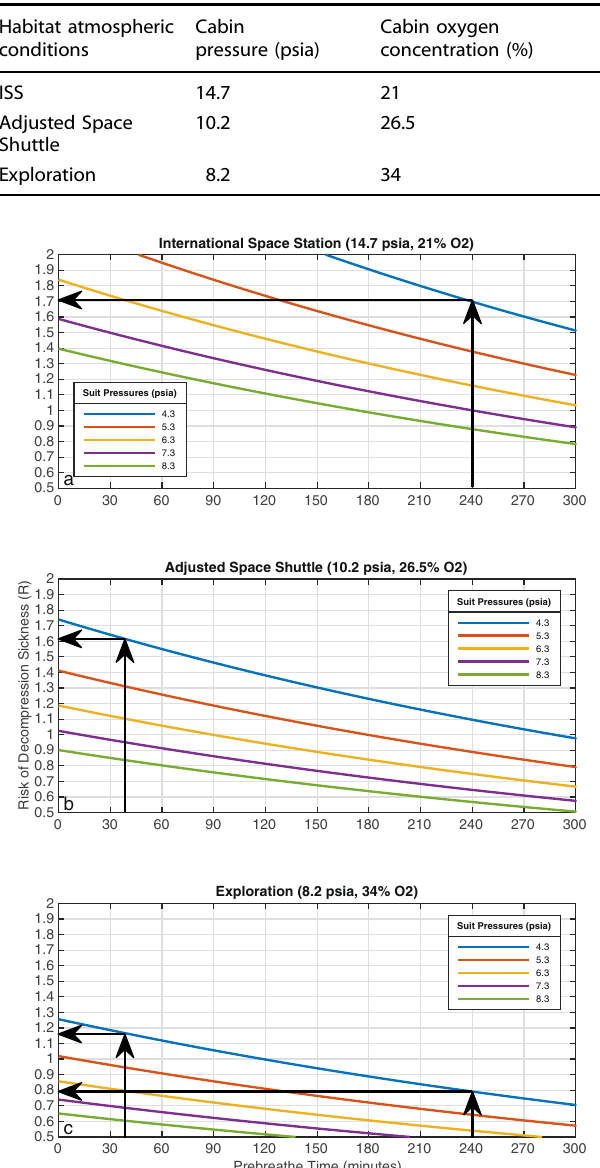
Fig. 2 The risk of decompression sickness (DCS) as a function of prebreathe time for multiple spacesuit pressures in ISS (top panel), Adjusted space shuttle (middle panel), and exploration (bottom panel) atmospheric conditions. At each atmospheric condition, higher spacesuit pressures require shorter prebreathe time to maintain a constant DCS risk. In addition, for a constant spacesuit pressure, atmospheric conditions with higher oxygen content (thus less nitrogen) require shorter prebreathe time to maintain a similar DCS risk. For example, in a mission scenario where the objective is to maintain a DCS risk below R = 1.7, a spacesuit at an operating pressure of 4.3 psia (e.g., EMU) requires a prebreathe time of 240 min in the ISS atmospheric conditions, 40 min in the Adjusted Space Shuttle atmospheric conditions, and no prebreathe time in the exploration atmospheric conditions. prebreathe of 240 min returns a DCS risk of R = 0.8 (for a spacesuit of 4.3 psia), while a 40-min prebreathe for the same spacesuit pressure yields a DCS risk of approximately R = 1.2 (Fig. 2, bottom panel). If the spacesuit is pressurized to 8.3 psia instead, the risk of